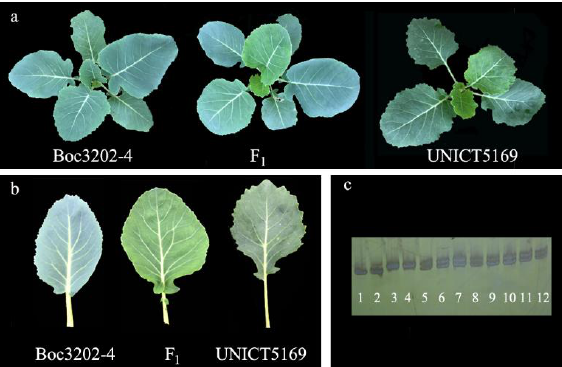
Figure 4. Identification of F 1 hybrids based on morphology and SSR molecular markers. ( a ) Plant morphology at the seedling stage. ( b ) Basal leaves of parental lines and the F 1 hybrid. ( c ) SSR analysis of parental lines and the F 1 hybrids: one and two, specific band for Boc3202-4; three and four, specific band for UNICT5169; 5–12, F 1 hybrids containing the bands from the parents.